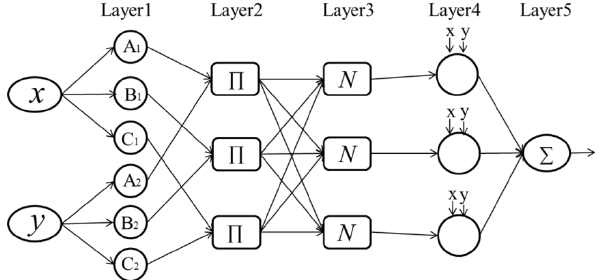
Figure 5. An ANFIS